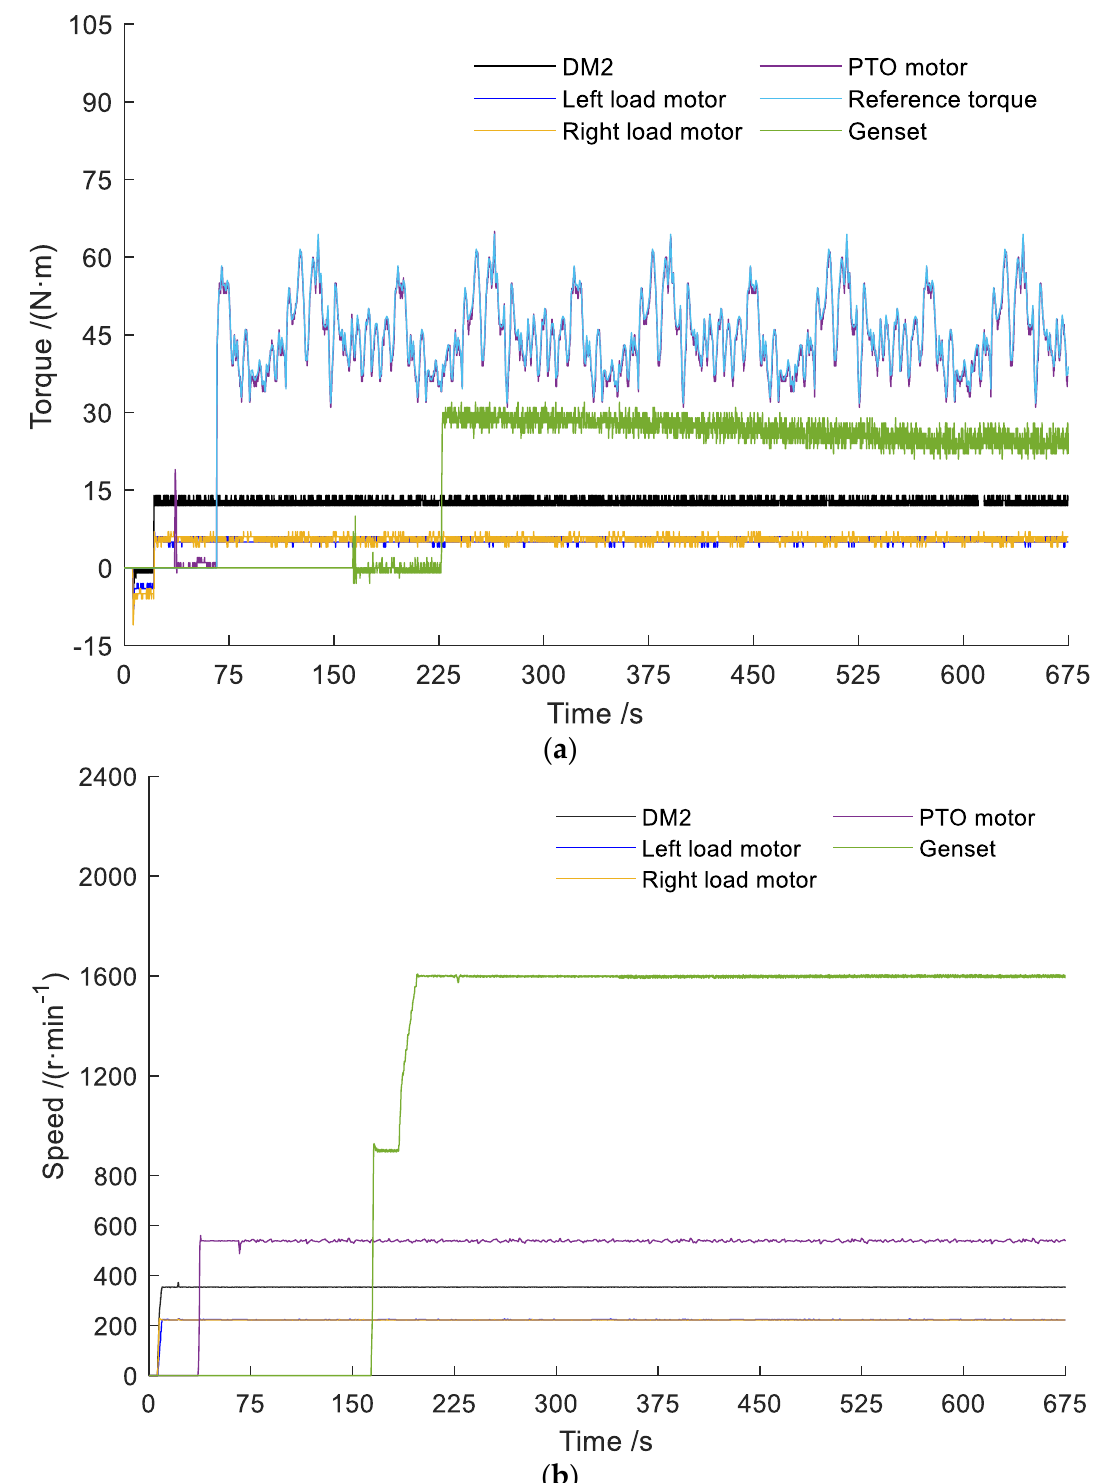
Figure 9. The experimental results under the rotary tillage operation: ( a ) speed curves; and ( b ) torque curves.